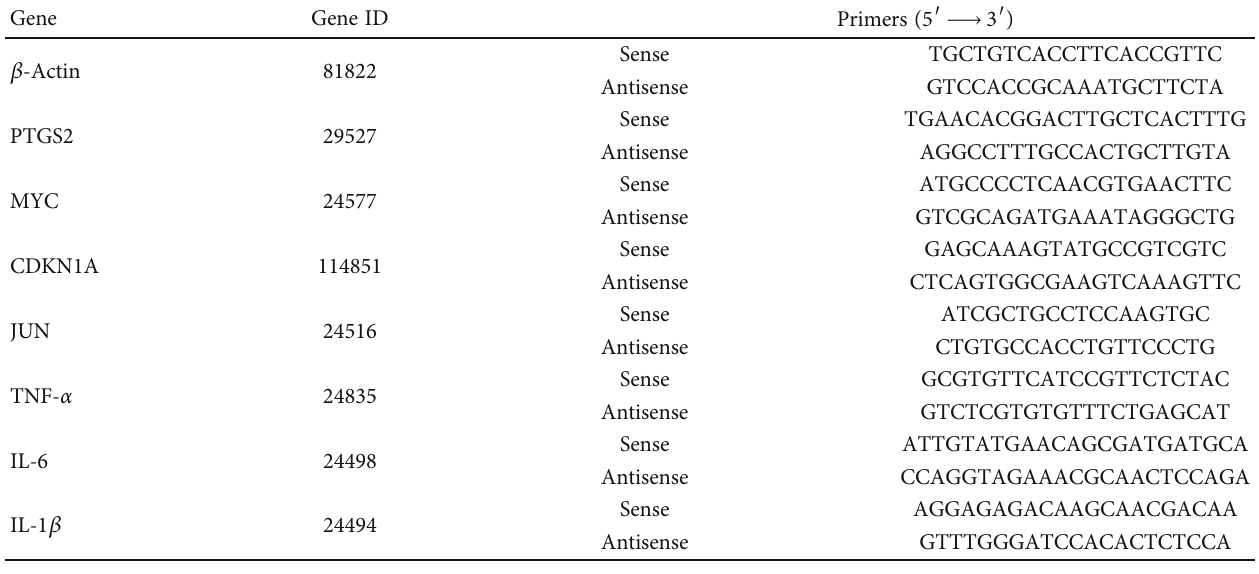
Table 1: mRNA primer sequences.